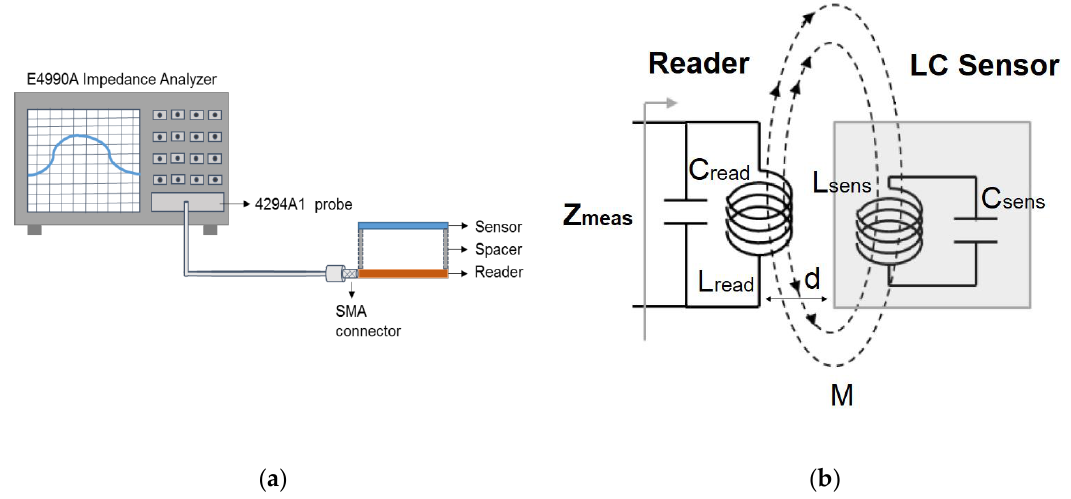
Figure 1. ( a ) Schematics of the set-up used for characterization. ( b ) Model circuit of the studied system.